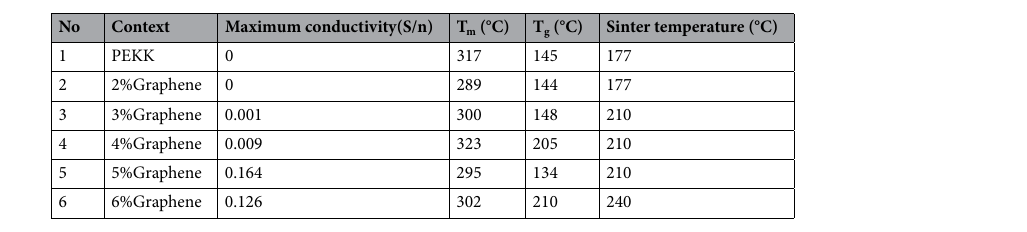
Table 2. The performance parameters of different graphene